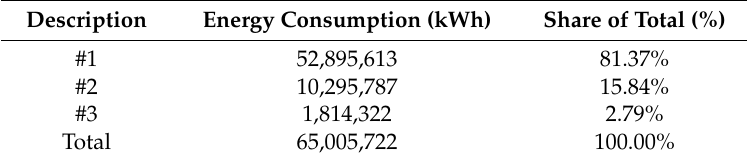
Table 5. Port of Valencia electricity consumption breakdown in 2016. Source: Valencia Port